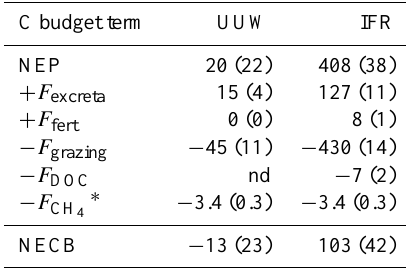
NEP, net ecosystem productivity; NECB, net ecosystem carbon budget; nd, not determined. ∗ The values for F CH4 originate from Laubach et al. (2016). They are given in their Table 3, in